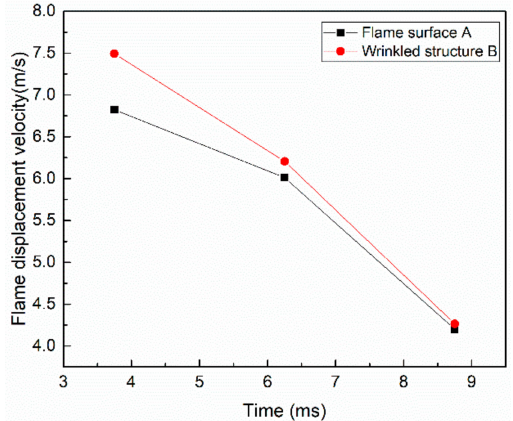
Figure 6. The displacement velocity of flame in forced ignition